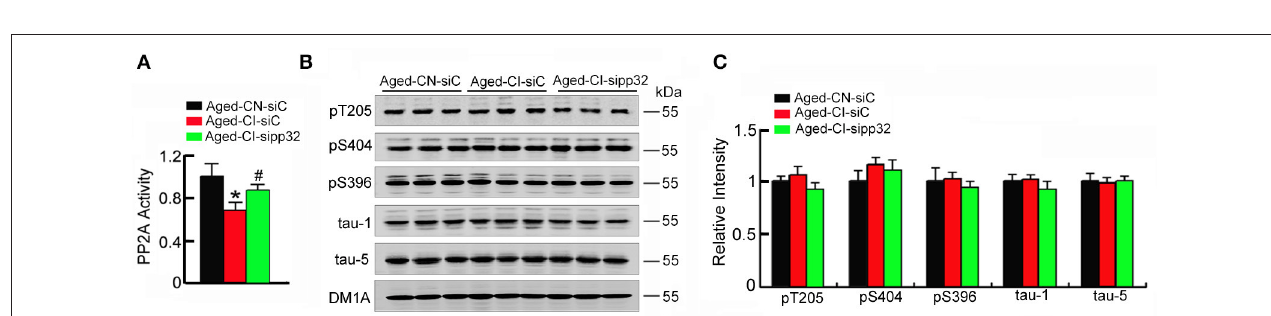
FIGURE 6 | Sipp32 has no effects on the phosphorylated tau levels. (A) PP2A activity in the hippocampal CA3 region of Aged-CN-siC, Aged-CI-siC, and Aged-CI-sipp32 animals were measured by using a Serine/Threonine Phosphatase Assay Kit ( n = 3–5 in triplicates). (B,C) Phosphorylated tau protein levels in the hippocampal CA3 region of Aged-CN-siC, Aged-CN-siC, and Aged-CI-sipp32 animals were detected by western blotting and quantitative analysis ( n = 3 for each group). * p < 0.05, vs. Aged-CN-siC; # p < 0.05 vs. Aged-CI-siC (mean ± SD